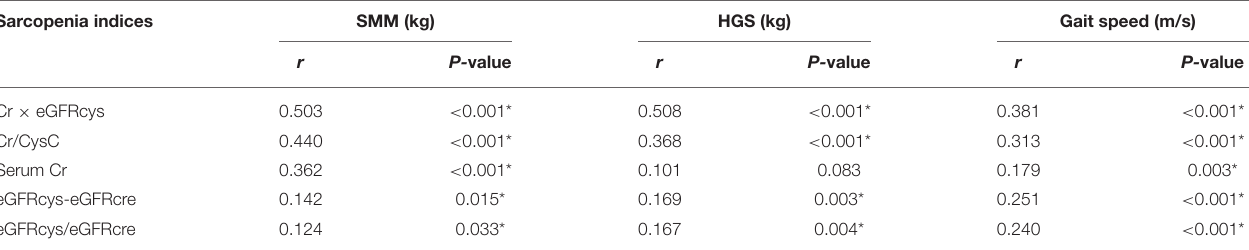
TABLE 2 | Spearman’s correlations between different proposed sarcopenia indices based on creatinine and cystatin C with skeletal muscle mass, strength, and gait speed. Sarcopenia indices SMM